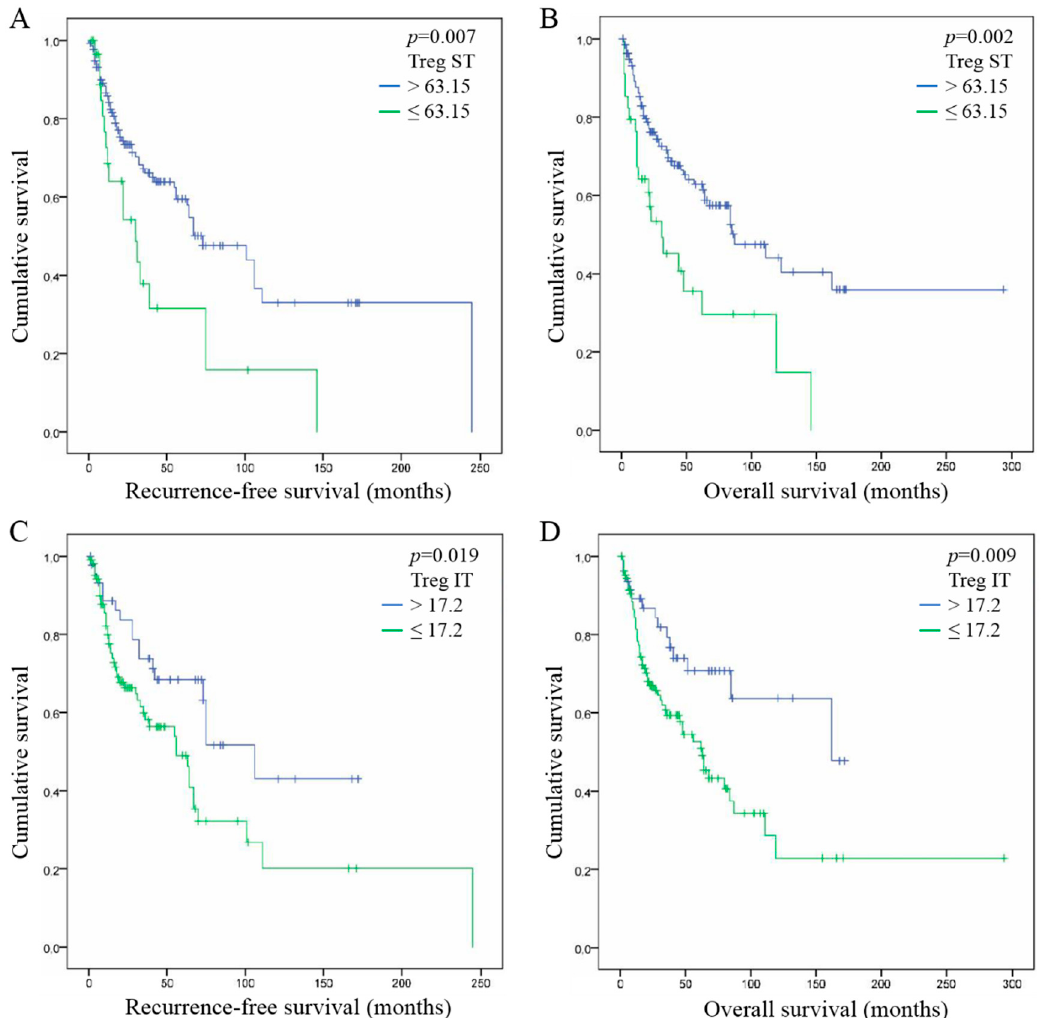
Figure 2. Association between FoxP3+ Treg infiltration and patient survival in HNSCC. ( A ) Association between FoxP3+ Tregs infiltration in the stromal compartment and recurrence-free survival (RFS) of patients. ( B ) Association between FoxP3+ Tregs infiltration in the stromal compartment and overall survival (OS) of patients. ( C ) Association between FoxP3+ Tregs infiltration in the intra-tumoral compartment and RFS of patients. ( D ) Association between FoxP3+ Tregs infiltration in the intra-tumoral compartment and OS of patients.